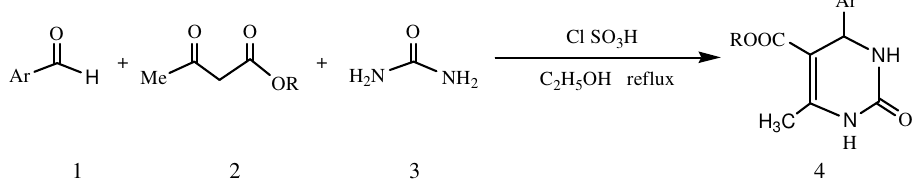
Experimental Materials and Measurements